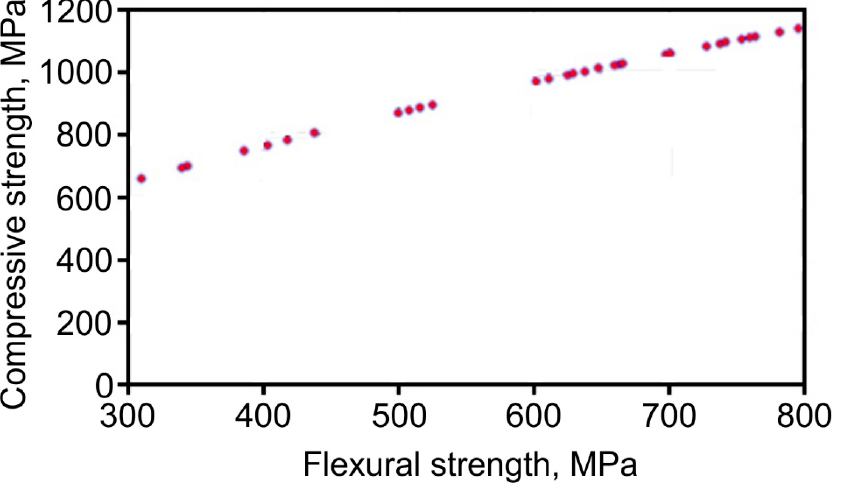
Figure 6. Relation between stresses studied.